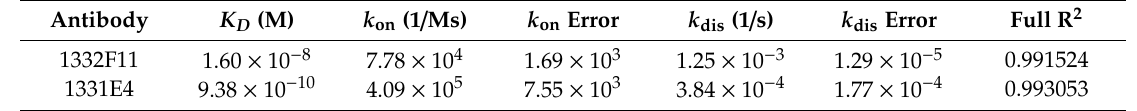
Table 1. Kinetics of NAb binding to RVFV Gn–Gc.